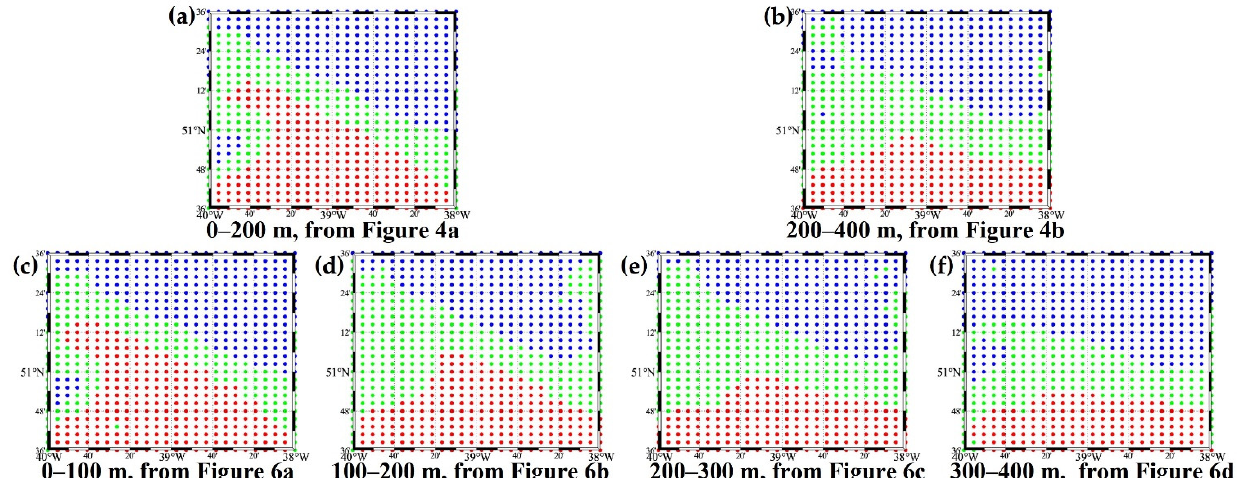
Figure 7. The comparisons of iterative hierarchical clustering results of sound speed profiles via K-means algorithm at 0–400 m. ( a , b ) are from Figure 4, and ( c – f ) are from Figure 6. It can be found that the result of 0–200 m is closer to that of 0–100 m, and the result of 200–400 m is closer to that of 200–300 m.